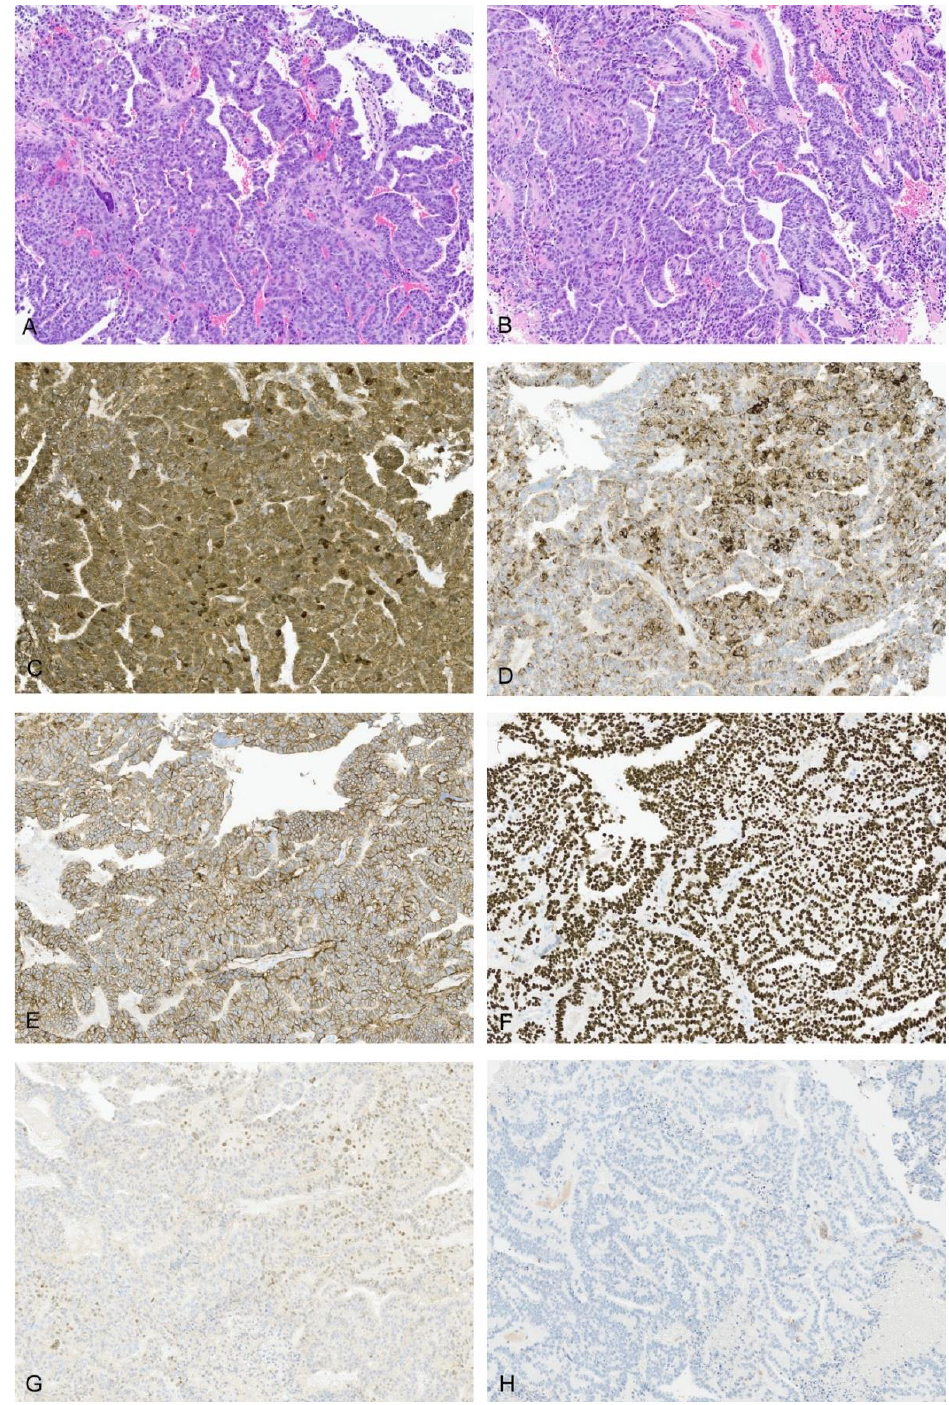
Figure 5. Teratoid HB peritoneal recurrence with tubulopapillary morphology, THB23. H&E 10x Teratoid HB peritoneal recurrence with tubulopapillary morphology, THB23. ( A , B ), beta-catenin IHC 10x ( C ), glypican-3 IHC 10x ( D ), MOC31 IHC 10x ( E ), SALL4 IHC 10x ( F ), H&E 10 × ( A , B ), beta-catenin IHC 10 × ( C ), glypican-3 IHC 10 × ( D ), MOC31 IHC 10 × ( E ), SALL4 PROX-1 IHC 10x ( G ), synaptophysin IHC 10x ( H ). IHC 10 × ( F ), PROX-1 IHC 10 × ( G ), synaptophysin IHC 10 × ( H